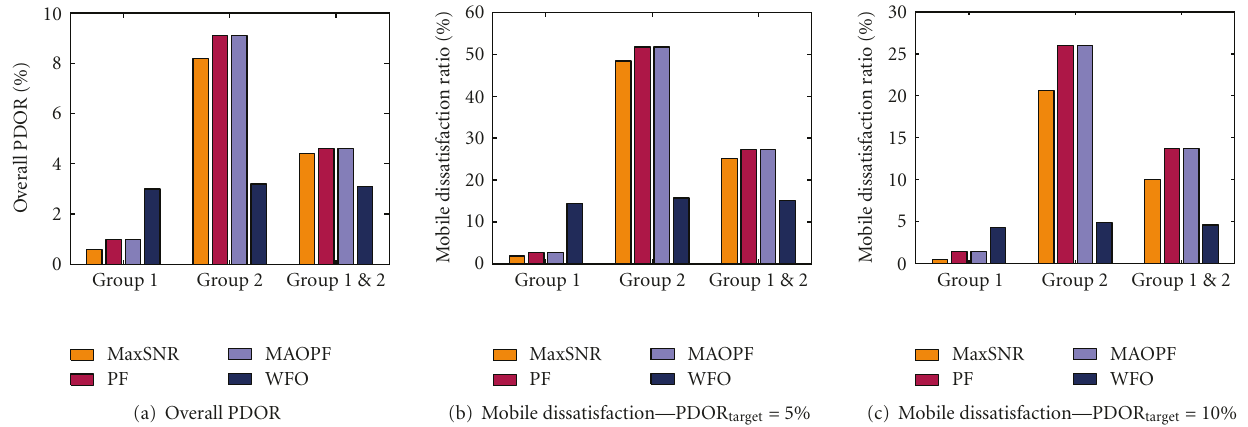
Figure 14: Measured QoS with heterogeneous sources in terms of delay requirement.